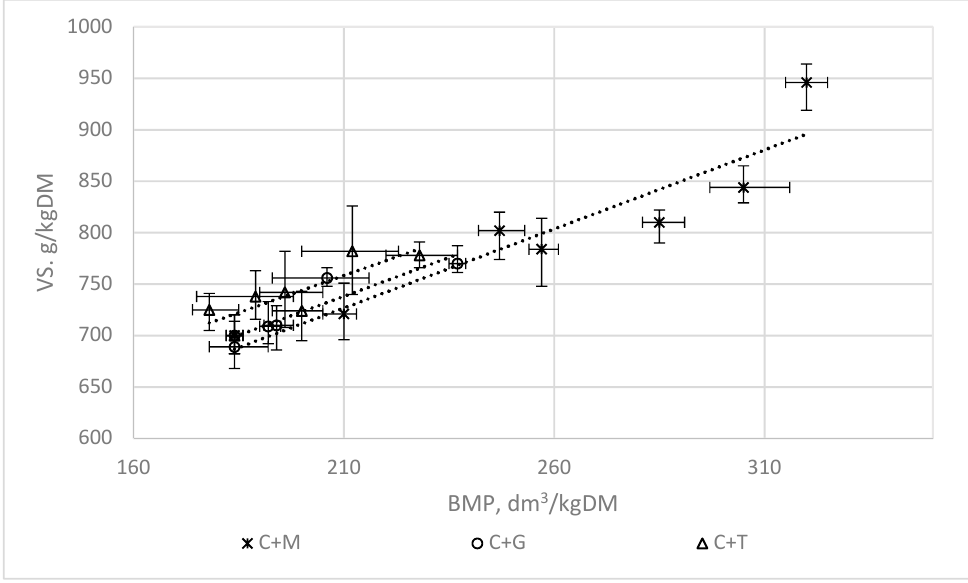
Figure 9 . The correlations between the VS index and the BMP . Figure 9. The correlations between the VS index and the BMP.